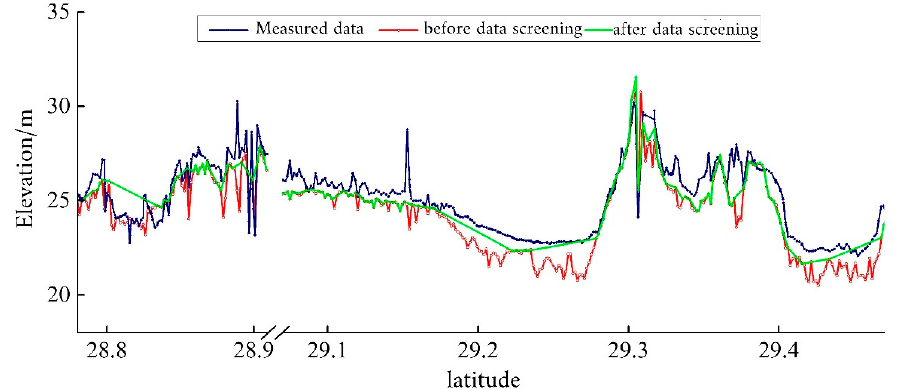
Figure 8. Comparison of the elevation before and after data screening of Ice, Cloud, and Land Elevation Satellite’s Geoscience Laser Altimeter System data at the footprint.